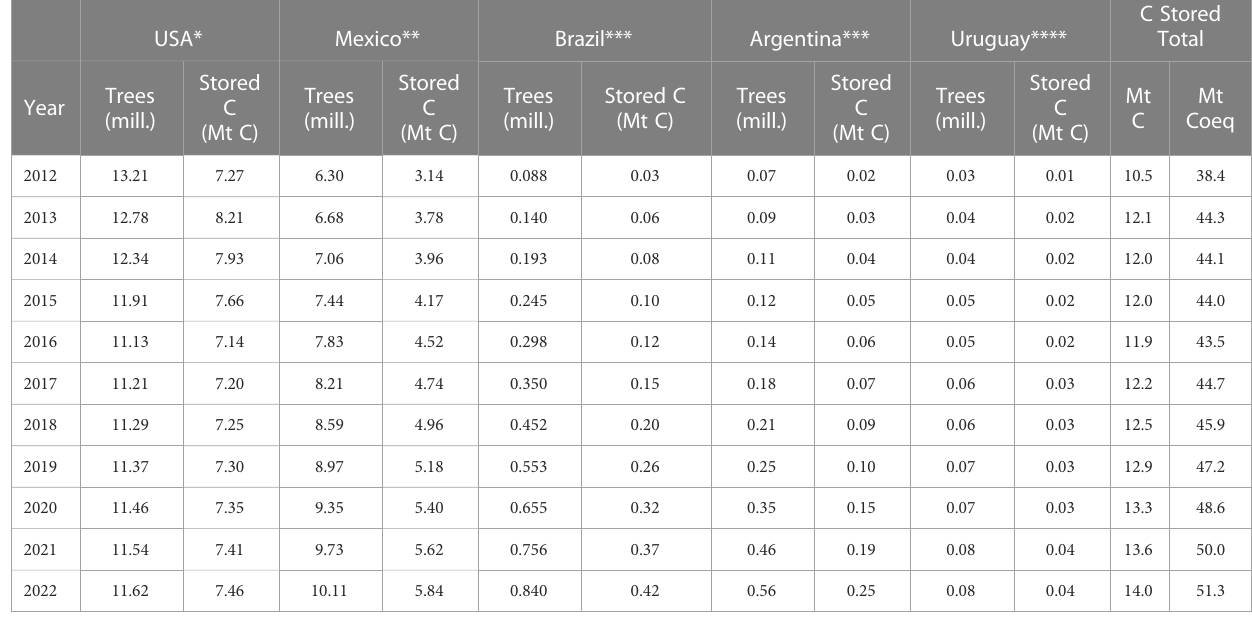
TABLE 3 Tree population and C stored in pecan trees ’ biomass during the period 2012-2022 for USA, Mexico, Brazil Argentina and Uruguay.